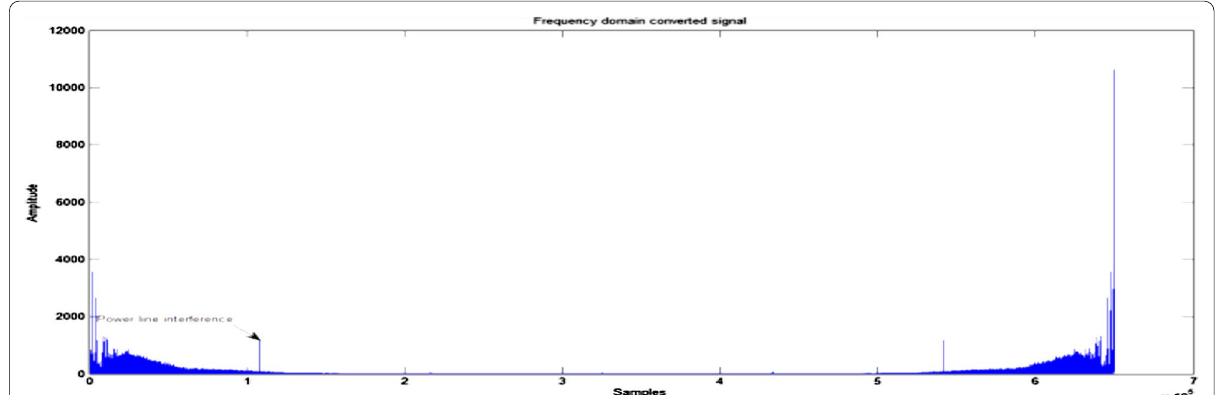
Fig. 9 FFT signal of record number 100 showing PLI: The raw ECG signal of record number 100 is converted to frequency domain by using fast Fourier transform which is showing power line interference noise at 60HZ